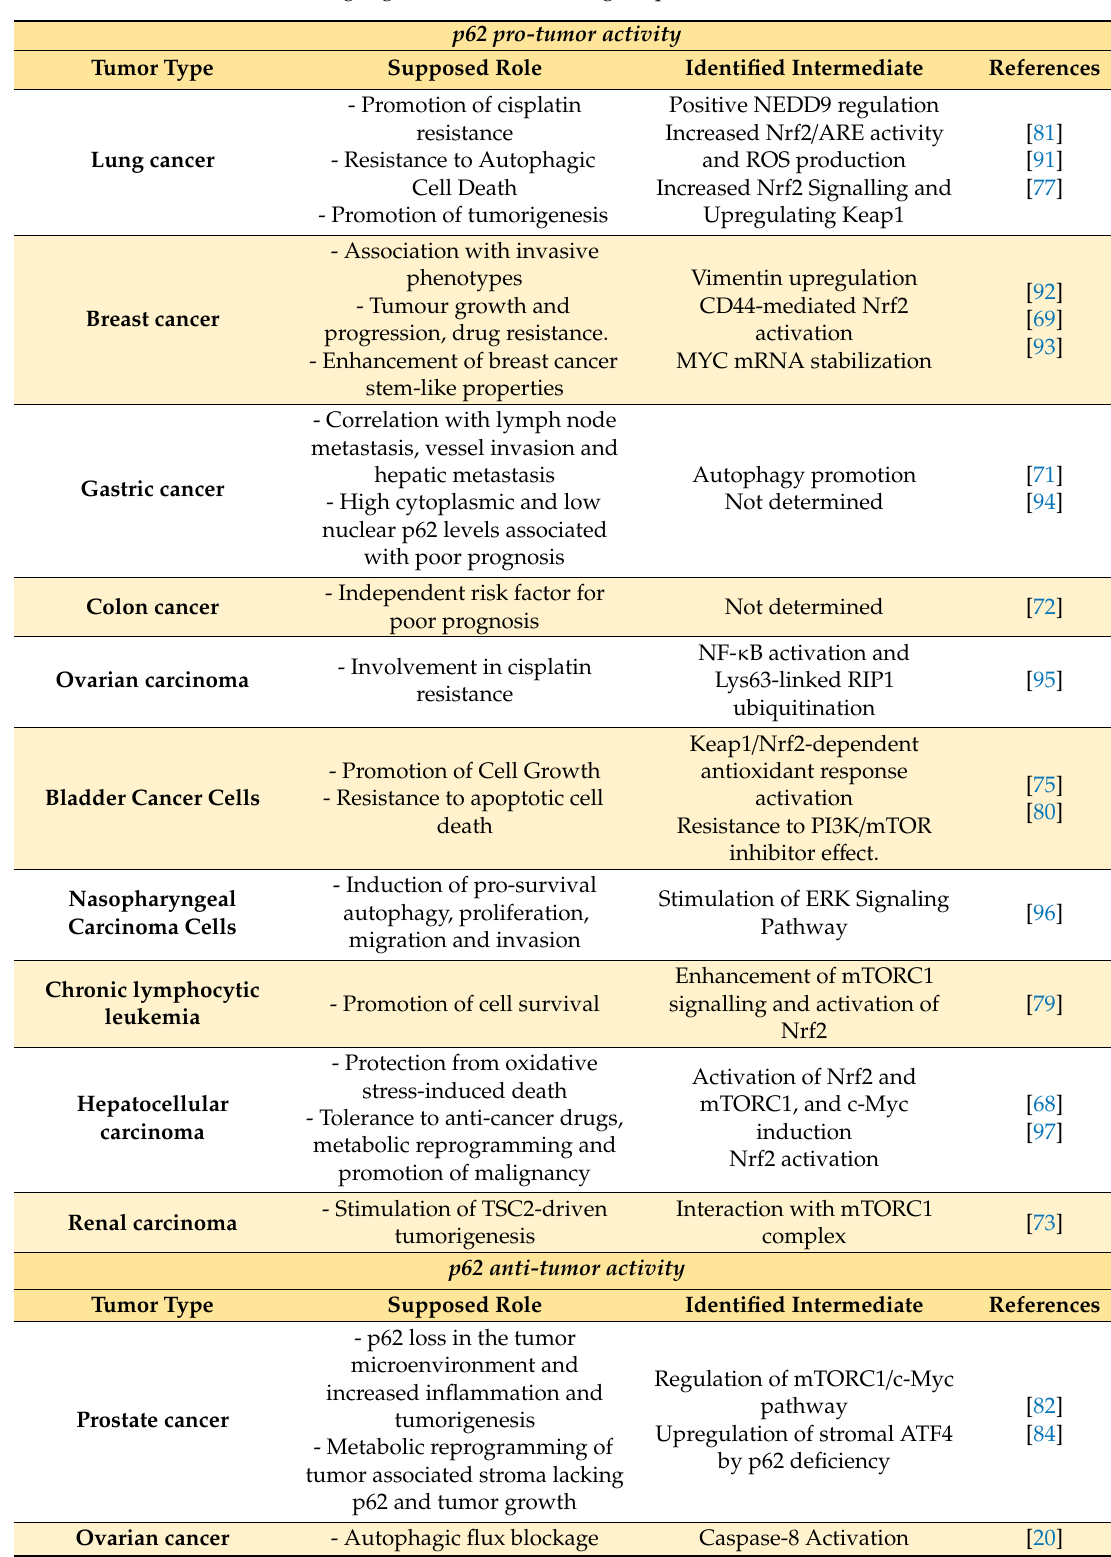
Table 1. Highlights of research findings of p62double role in